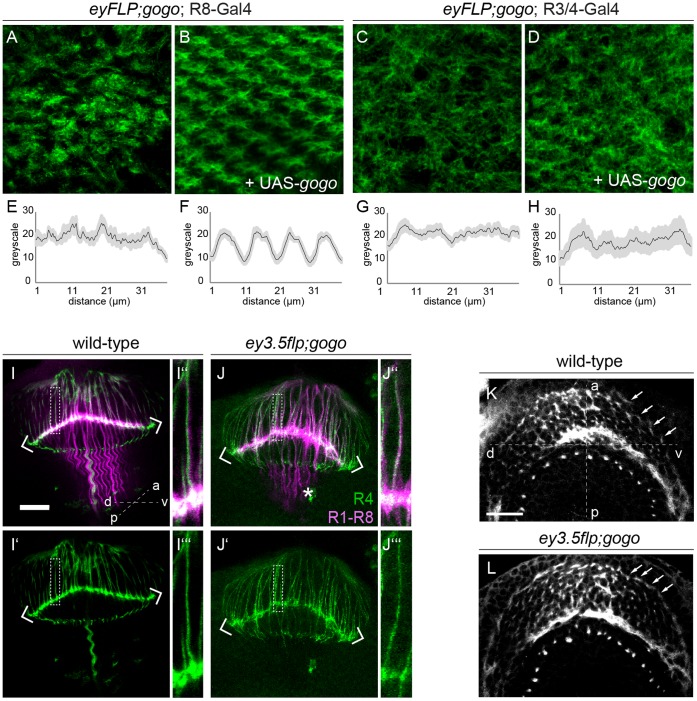
Gogo function in R8 is sufficient to maintain retinotopic map formation.(A–D) Pupal lamina in eyflp;gogo eyes (control) and specific rescue experiments stained with mAb24B10 and plot profiles. (A, C) Absence of Gogo in the majority of R axons and the target area strongly disrupts the overall pattern of the pupal lamina (42 hr APF). (B) When FL Gogo is specifically restored in R8 axons the orderly organized pattern of the topographic map is fully rescued. (C) However, FL Gogo expression in R4 axons in the mutant background cannot restore the orderly arrangement of cartridges. (E–H) Pooled plot profiles of 4 cartridges in each experiment provide an example of the pattern regularity. The R8 rescue displays a periodic profile while in mutant controls and R4 rescue a periodicity is not detectable. (I-J’’’) Larval optic lobes in control and gogo mosaic animals and corresponding magnifications. mAb24B10 staining visualizes R1–R8 axons (magenta) and GFP is expressed in the R4 subtype (green). While gogo mutant axons strongly bundle within the medulla (asterisk), mutant R cell targeting to the lamina plexus (defined by chevrons) shows only mild irregularities compared to wild-type. Single wild-type (I’’) and gogo mutant (J’’) R4 axons strictly remain within their fascicle. (K, L) In eyflp;gogo eyes R fascicle (white arrows) distribute along the anterior-posterior axis indistinguishable from wild-type. a: anterior; p: posterior; d: dorsal; v: ventral. Scale bars: 20 µm.